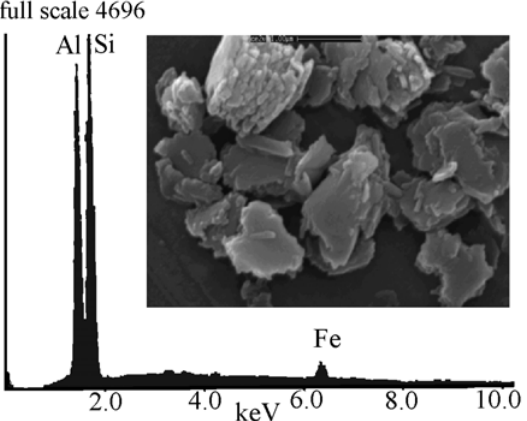
Fig. 6 – Iron-rich platy crystals of kaolinite forming stacks in the veins (CE2v). The iron was detected by the EDX Analyses with the